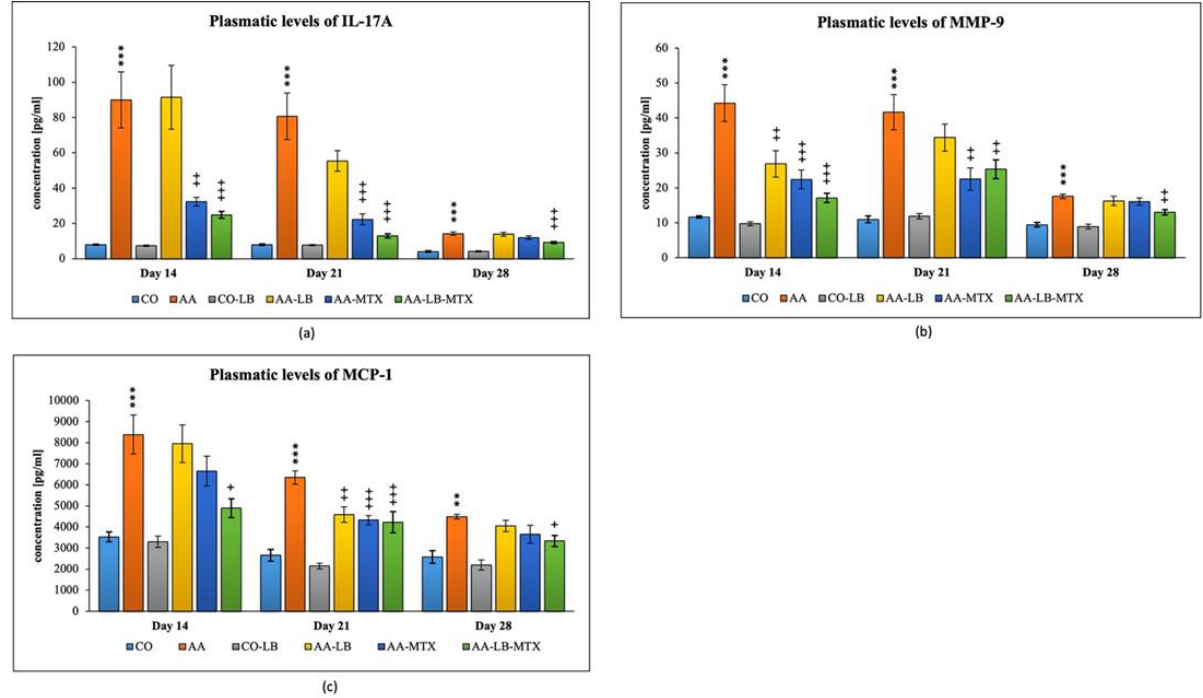
Figure 3. The effect of L. plantarum on several biochemical markers such as IL-17A ( a ), MMP-9 ( b ), and MCP-1 ( c ), was measured on different experimental days 14, 21, and 28. CO — healthy control group, AA — group of controls with adjuvant arthritis (AA), CO-LB — a control group of healthy animals administered with L. plantarum (LB), AA-LB — group of animals with AA administered with LB, AA-MTX — rats with AA treated with methotrexate (MTX), AA-LB-MTX — group of rats with AA receiving combinational therapy of MTX and LB. Values are expressed as mean ± S.E.M. Statistical significance was evaluated by applying ANOVA for independent variables: *** p < 0.001, ** p < 0.01 vs. CO group; +++ p < 0.001, ++ p <0.01, + p < 0.05 vs. AA group.